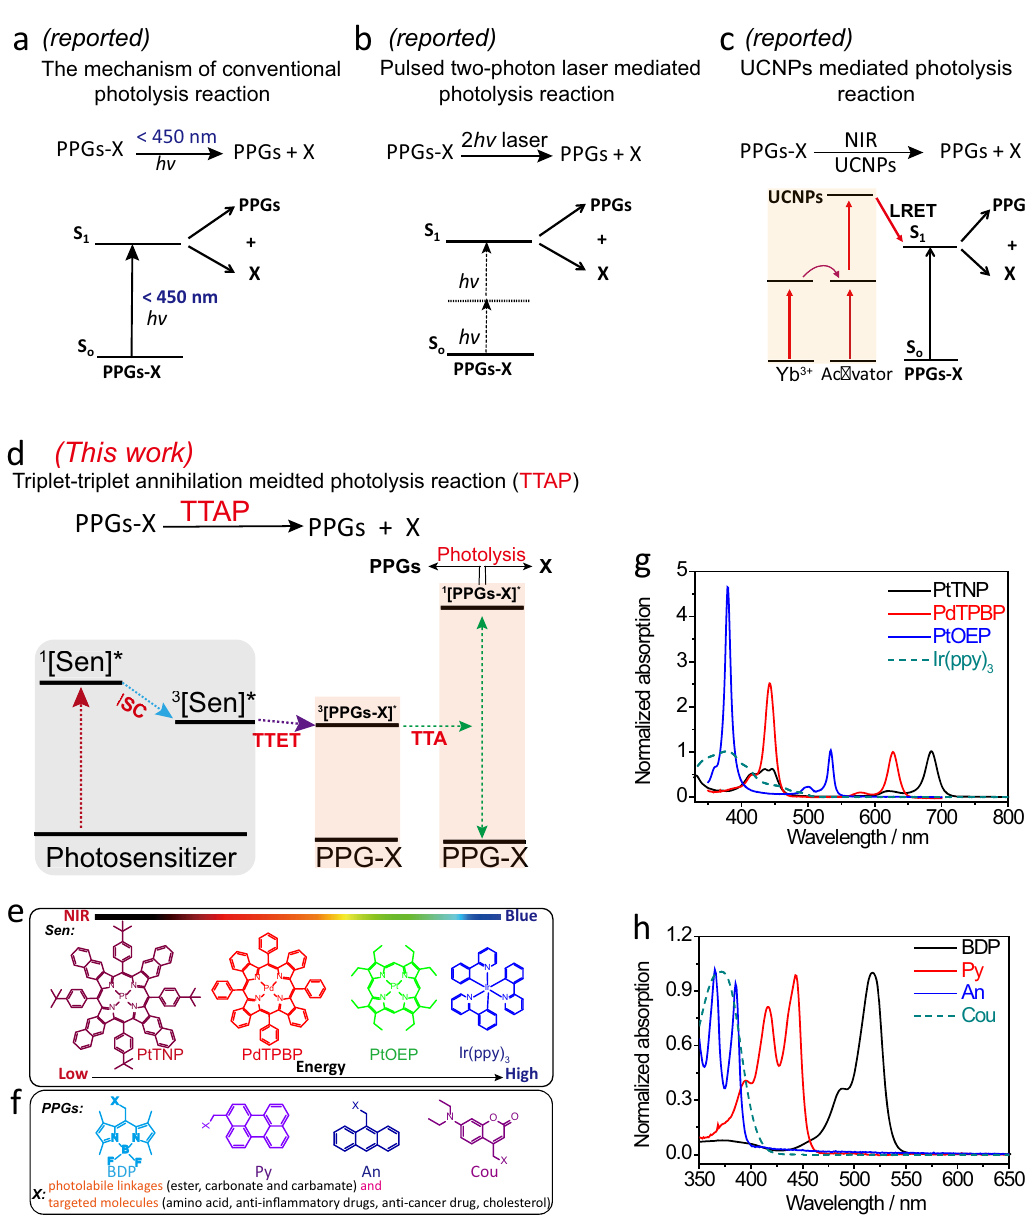
Fig. 1 The mechanism of reported state-of-the-art photolytic reactions and the TTAP mechanism in this work. a The reported mechanism of conventional photolytic mechanism. hv : single photon. b Pulsed two photon laser strategy mechanism for photolytic reaction. 2 hv : two photon. c The reported lanthanide ion-doped upconversion nanoparticles (UCNPs)-mediated photolytic reaction. LRET luminescence resonance energy transfer. d The mechanism of triplet – triplet annihilation-mediated photolysis (TTAP, this work). ISC intersystem crossing, TTET triplet – triplet energy transfer, TTA triplet – triplet annihilation, 1 [Sen] * the singlet excited state of the photosensitizer, 3 [Sen] * the triplet excited state of the photosensitizer, PPGs-X a photolytic molecule, PPGs photoremovable protecting groups (BDP, Py, An, and Cou), X targeted molecules (amino acids, anti-in fl ammatory drugs, anti- cancer drug, cholesterol), and photolabile linkage (ester bond, carbonate, carbamate). e Molecular structures of photosensitizers, including PtTNP, PdTPBP, PtOEP, and Ir(ppy) 3 . f Molecular structures of PPGs, including BDP, Py, An, and Cou moieties. g The normalized UV – vis absorption spectra of photosensitizers. h The normalized UV – vis absorption spectra of absorbing photosensitizer PdTPBP, compound 7 with PPG of BDP ( T 1 = 1.49 eV) and compound 8 with PPG of perylene exhibited obvious quenching effects on the photoluminescence of PdTPBP ( T 1 = 1.55 eV) (Supplementary Figs. 9 and 10). Moreover,